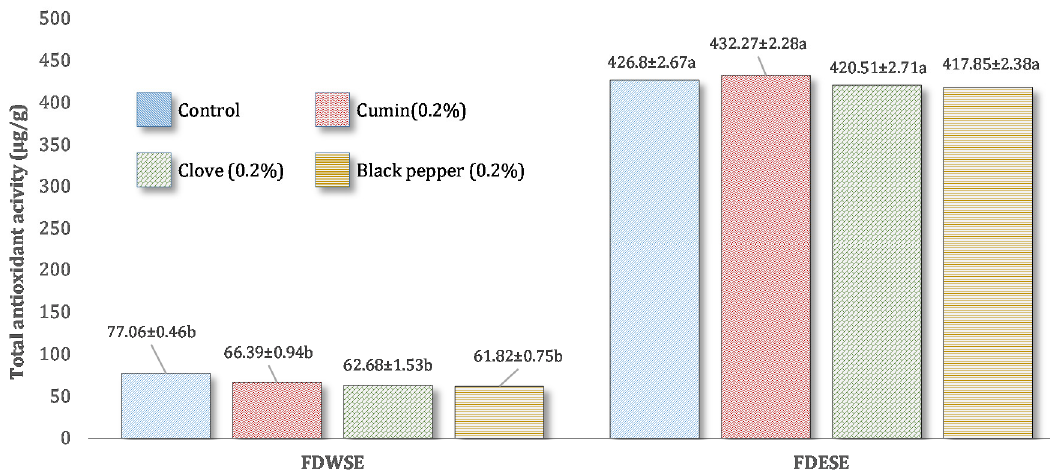
Figure 2. Mean values for Total atioxidant activity (TAA) of freeze-dried water-soluble (WSE) and ethanol-soluble extract (ESE) of processed Cheddar cheese made from buffalo milk after ripening. a,b means followed by the same letter for each type of processed Cheddar cheese are not significantly different ( p <